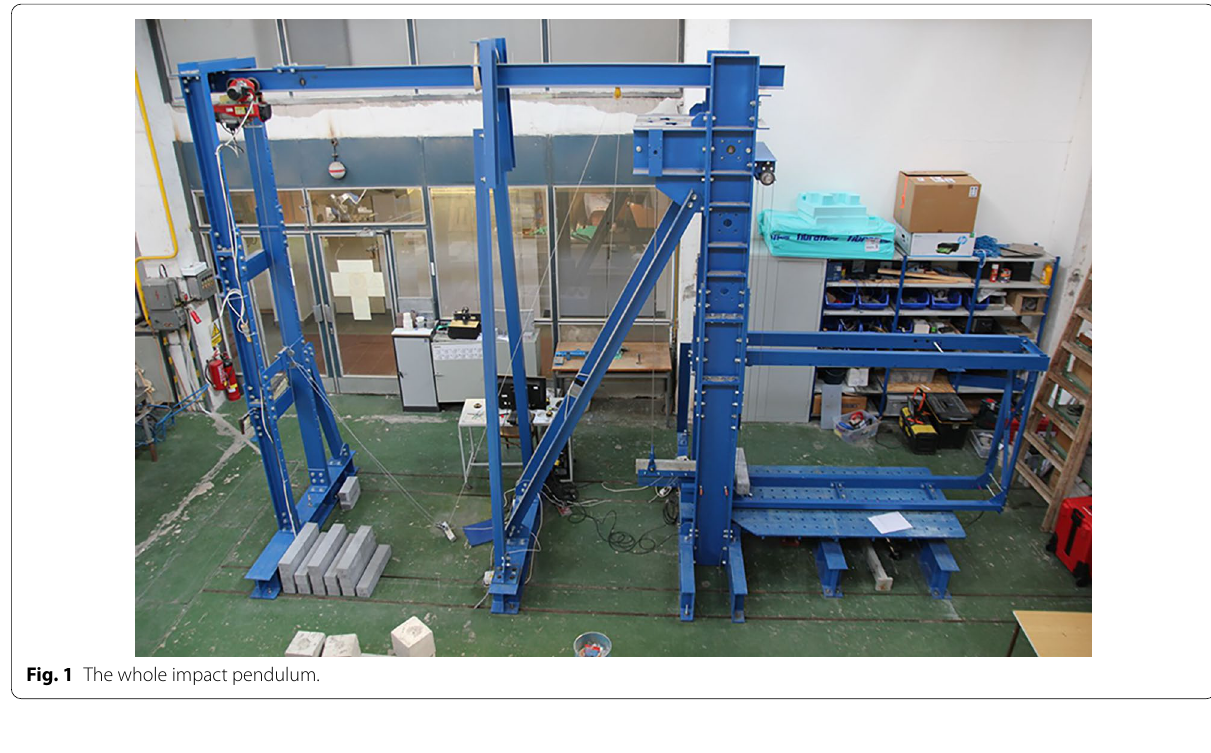
Fig. 1 The whole impact pendulum.